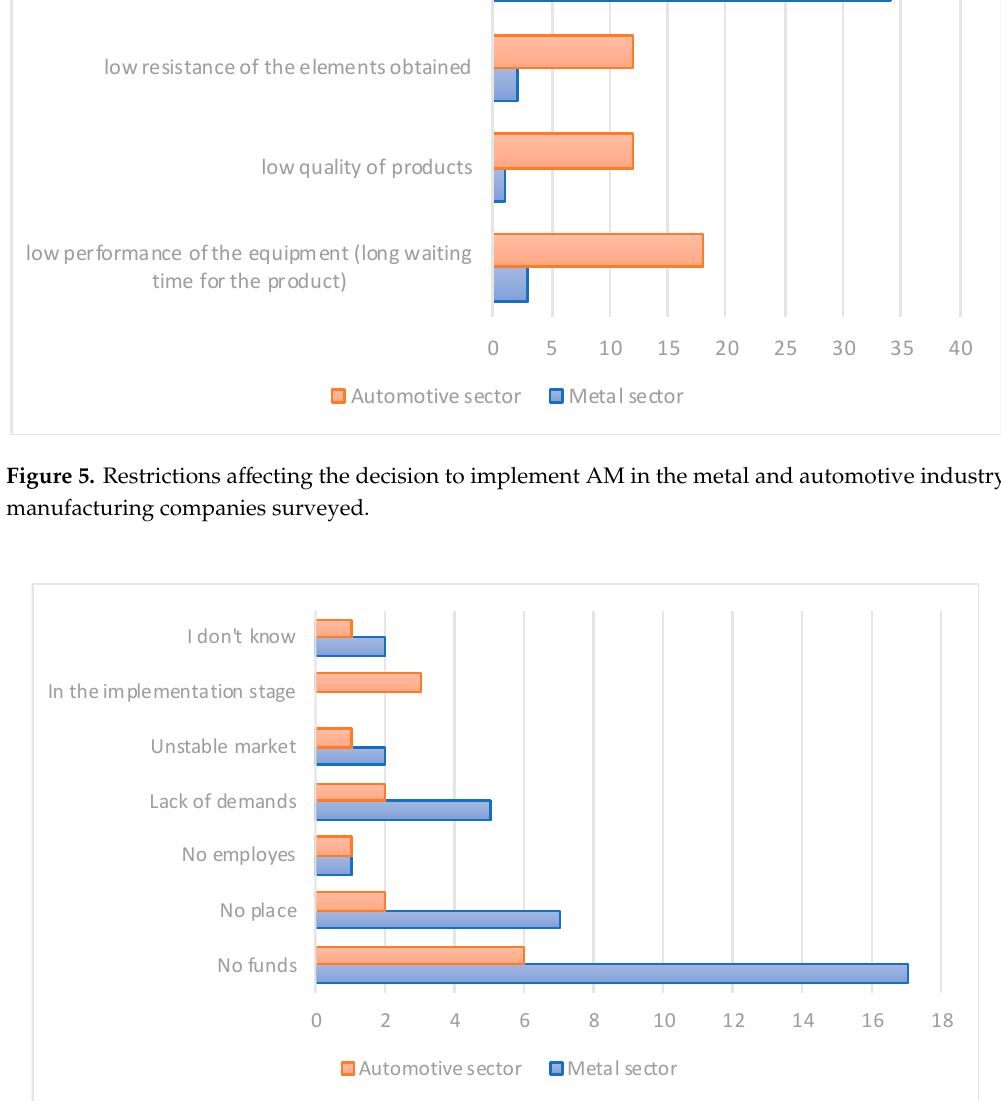
Figure 6. Restrictions affecting the decision to implement AM, in the metal and automotive industry manufacturing companies surveyed. Answers given by the respondents.